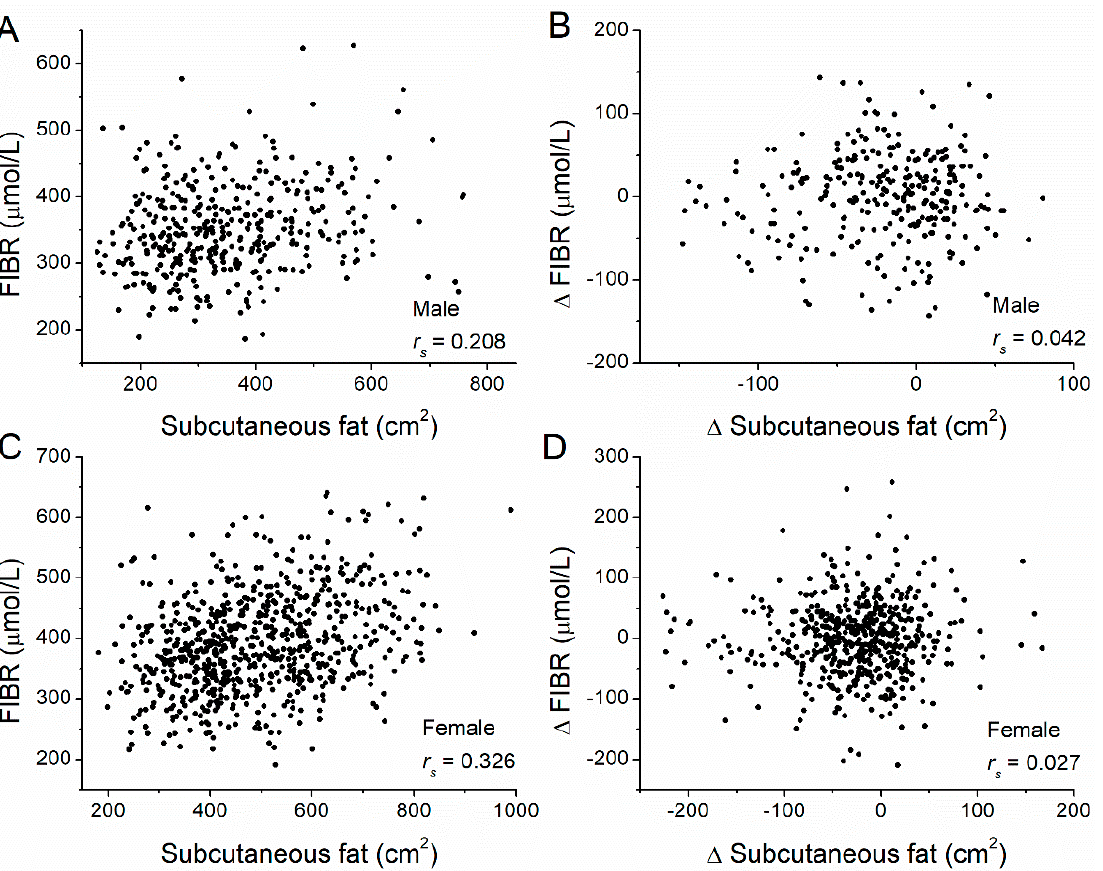
Figure 4. Correlations between subcutaneous adipose tissue (SAT) volume and FIBR levels, and between their changes. Correlations between ( A ) SAT and the FIBR level ( r s = 0.208, p < 0.001), and between ( B ) changes in VAT and changes in FIBR levels ( r s = 0.042, p = 0.475) in male participants of the diabetes prevention program. Correlations between ( C ) VAT and the FIBR level ( r s = 0.326, p < 0.001), and between ( D ) changes in VAT and changes in FIBR levels ( r s = 0.027, p = 0.543) in female participants. Adipose tissue volume was measured at baseline and the one-year follow-up by com- puted tomography at the L4–L5 level. Δ = value (year 1) − value (baseline) , where values correspond to fat volume or FIBR. The Spearman’s rank correlation coefficient, r s , was calculated.